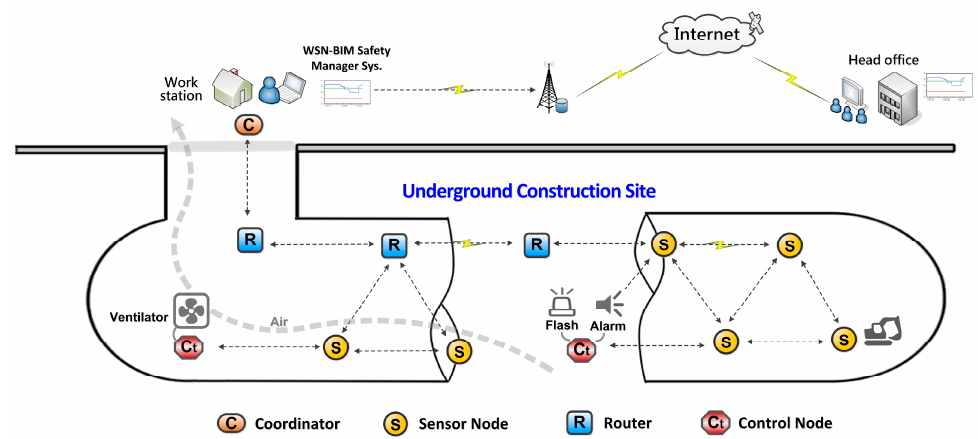
Figure 1. The concept of the hazardous gas detection system.